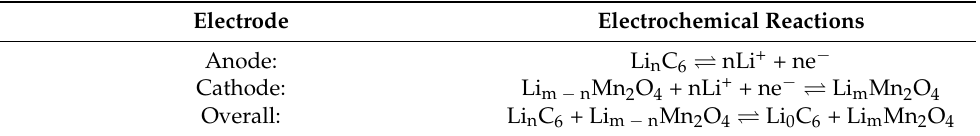
Table 3. Electrochemical reactions of a lithium manganese oxide (LMO) battery.